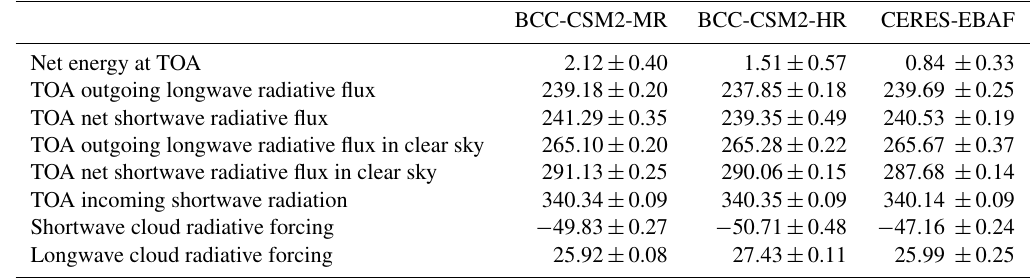
Table 2. Energy balance and cloud radiative forcing at the top of the atmosphere (TOA) in the models in contrast to CERES-EBAF observa- tions. Units: Wm − 2